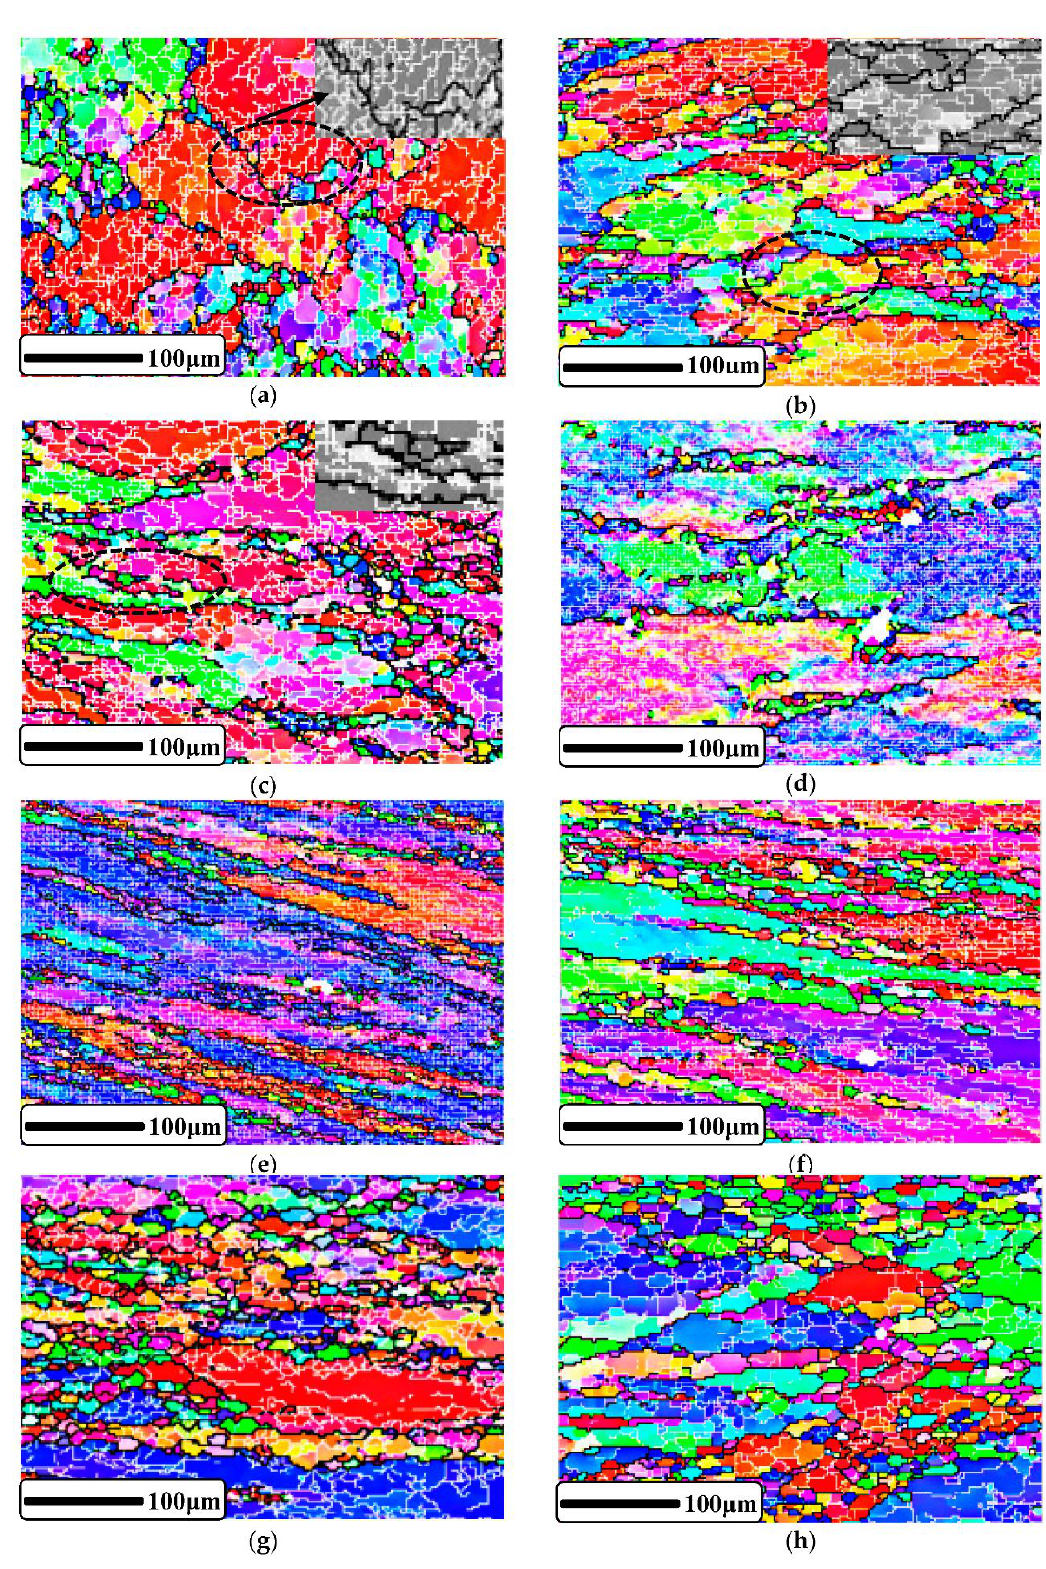
Figure 10. The EBSD micrographs of the deformed samples under conditions of: ( a ) 673 K and 0.1 s −1 with the strain of 0.2; ( b ) 673 K and 0.1 s −1 with the strain of 0.5; ( c ) 673 K and 0.1 s −1 with the strain of 0.9; ( d ) 623 K and 1 s −1 with the strain of 0.9; ( e ) 673 K and 1 s −1 with the strain of 0.9; ( f ) 773 K and 1 s −1 with the strain of 0.9; ( g ) 773 K and 0.1 s −1 with the strain of 0.9; ( h ) 773 K and 0.01 s −1 with the strain of 0.9.